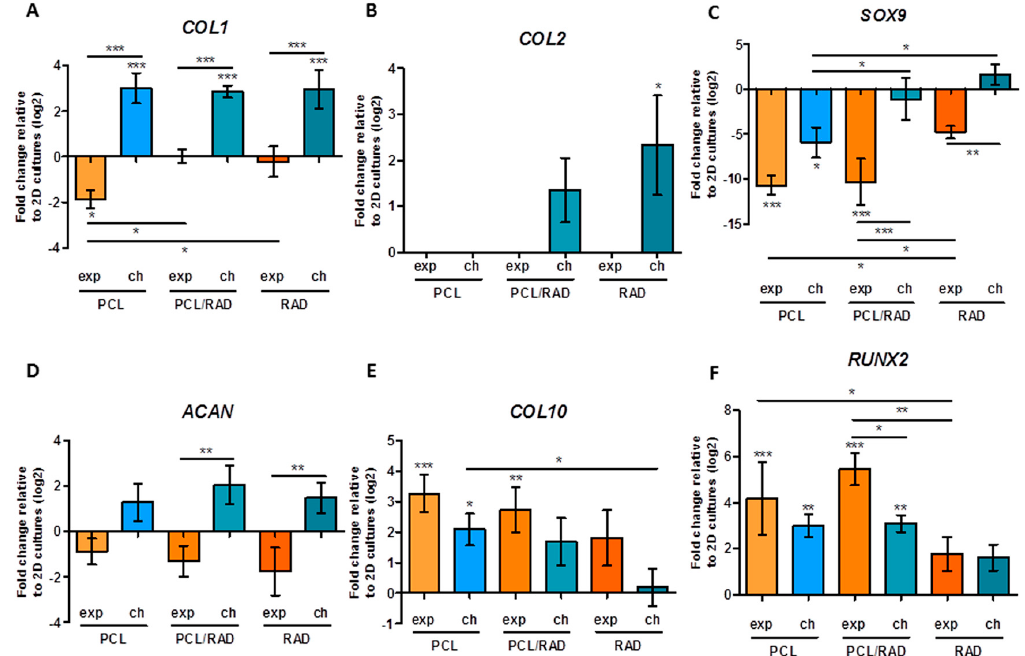
Figure 3. Gene expression levels of chondrogenic and hypertrophic markers of Articular Chondrocytes (AC) cultured in 3D scaffolds over 4 weeks. AC in PCL, PCL/RAD and RAD scaffolds were analyzed for gene expression in expansion (exp) and chondrogenic (ch) media. Collagen type I (COL1, A ); collagen type II (COL2, B ); SOX9 ( C ); aggrecan (ACAN, D ); collagen type X (COL10, E ); and RUNX2 ( F ) were determined through qRT-PCR. Ct values relative to ribosomal protein L22 (RPL22) were obtained and reported as fold increase ( ΔΔ Ct) relative to 2D cultures in expansion medium (baseline) (Statistical differences are indicated as: * for p < 0.05, ** for p < 0.01, and *** for p < 0.001, One-way ANOVA, N = 2 n = 3).